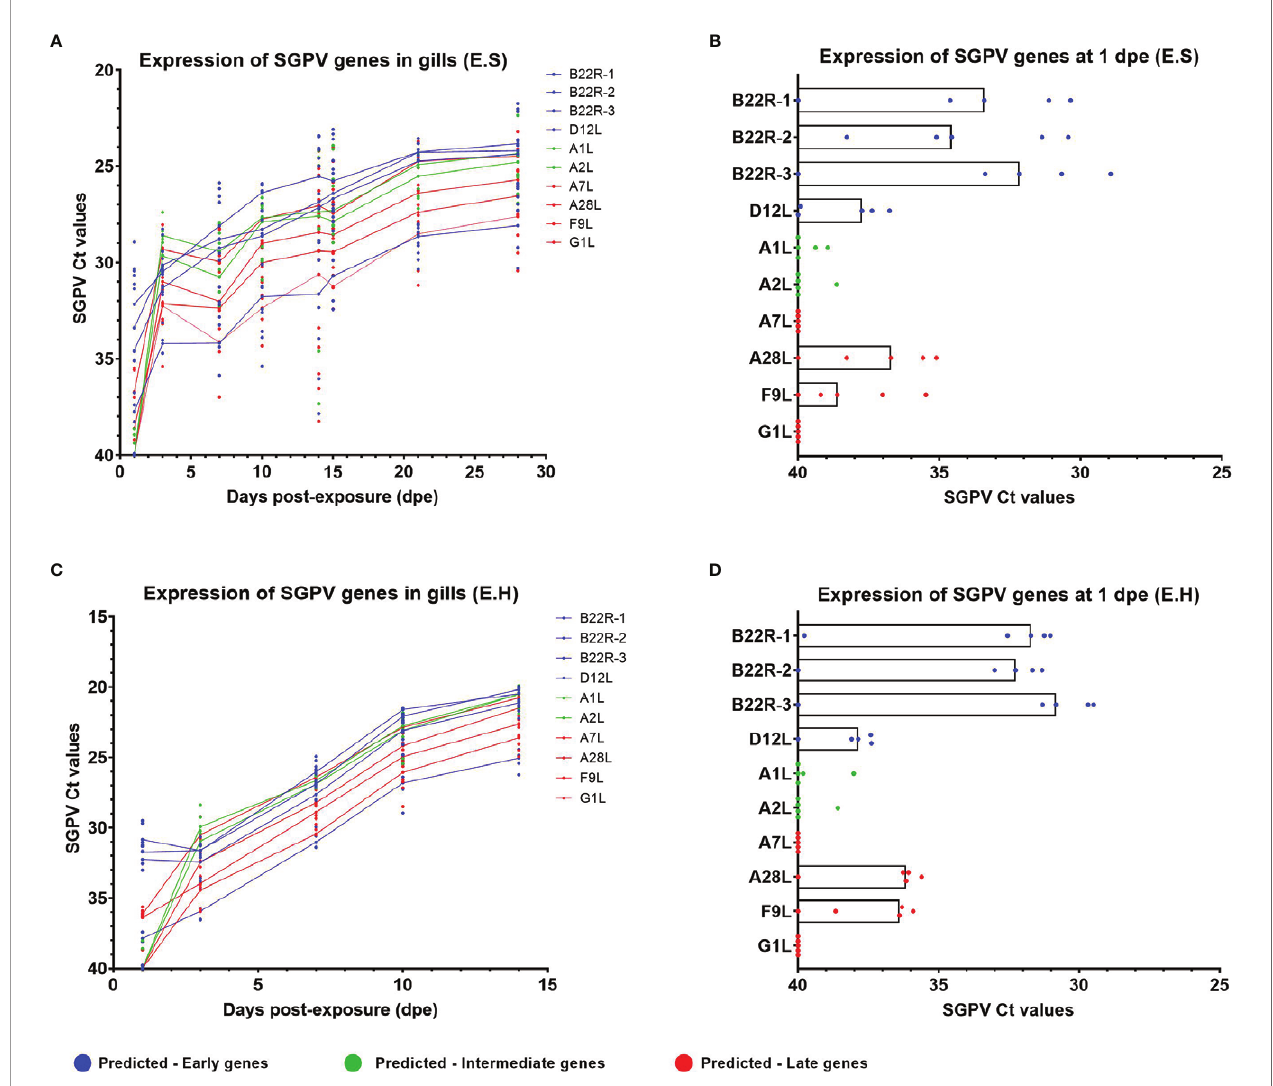
FIGURE 1 | Expression of SGPV genes predicted as early-, intermediate- and late based on the Vaccinia virus (11). Each dot represents data from one individual salmon and the solid line represents the median value for each group. Predicted early genes are marked in blue, predicted intermediate genes in green and predicted late genes in red. (A) Expression of SGPV genes for the E.S group from day 1 to day 28 in the experimental trial. (B) Highlight from day 1 post-exposure for the E.S group. (C) Expression of SGPV genes for the E.H group from day 1 to day 14 in the experimental trial. (D) Highlight from day 1 post-exposure for the E.H group. E.S, SGPV-exposed sham injected group; E.H, SGPV-exposed hydrocortisone-injected